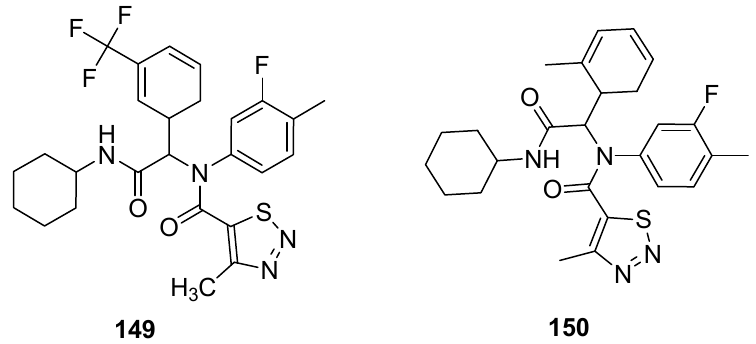
Figure 32. The most active 4-methyl-1,2,3-thiadiazole-5-carboxamides.